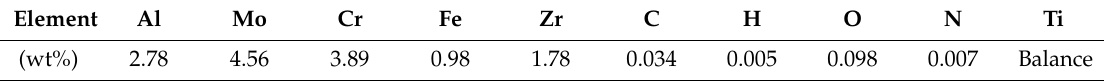
Table 1. Chemical composition of the as-received Ti-35421